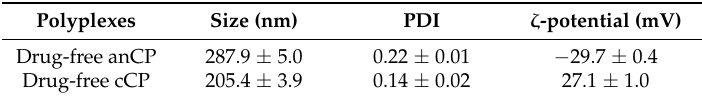
Table 1. Summary of characteristics of representative drug-free (plain) polyplexes. All measurements were conducted in triplicates. n = 3, mean ±